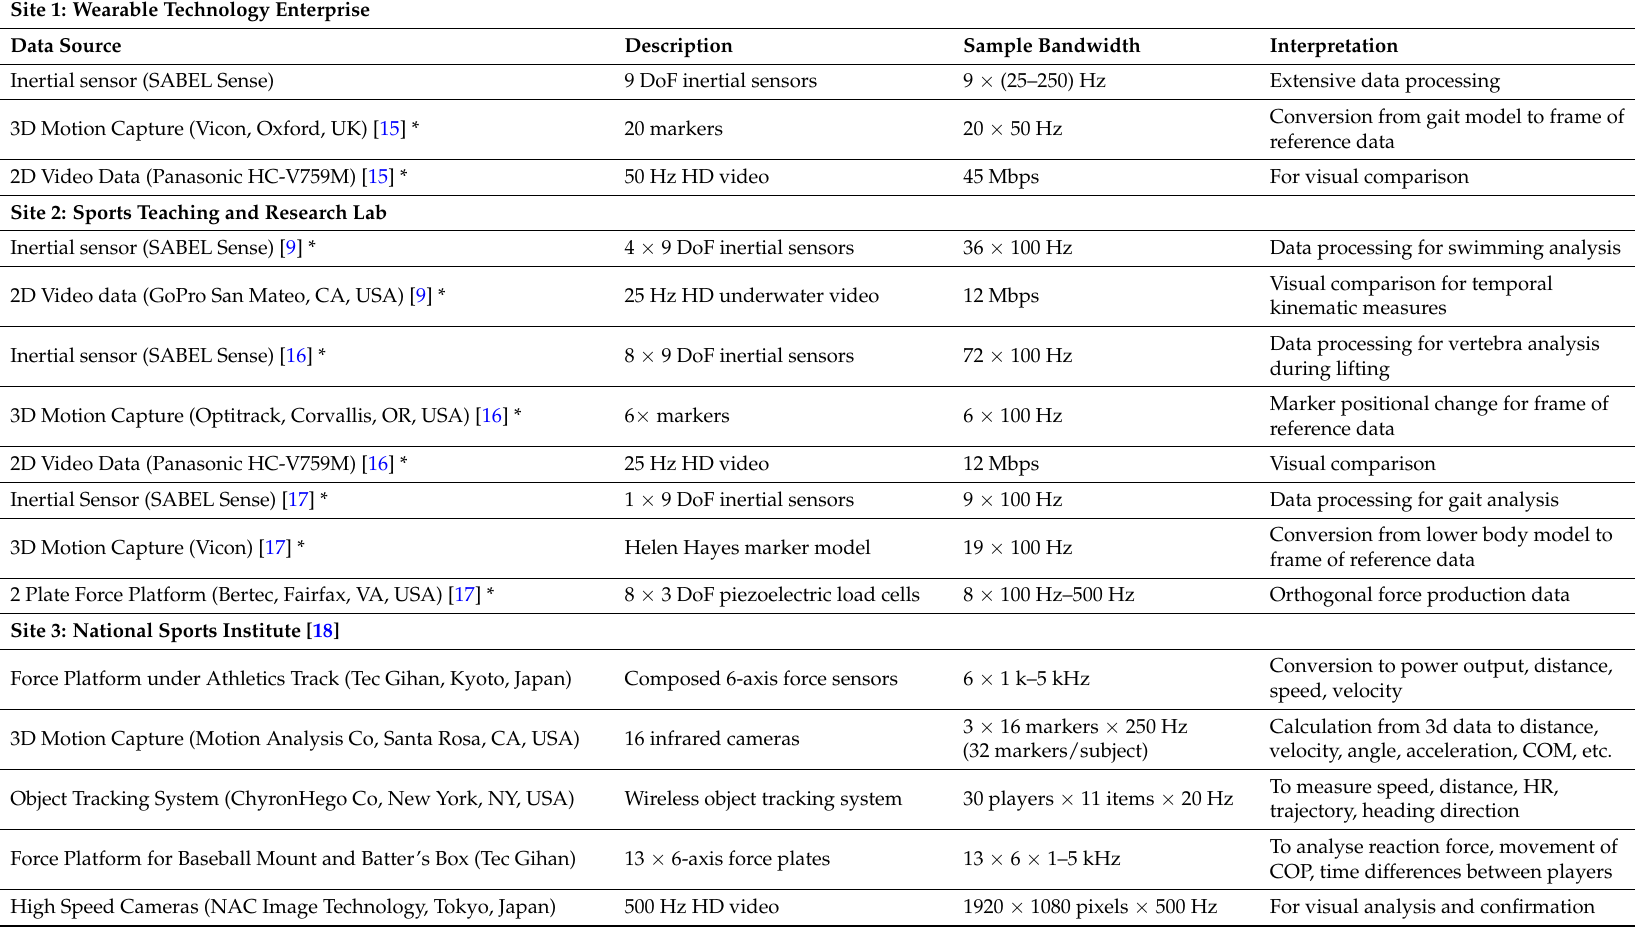
Table 1. Sample deployment